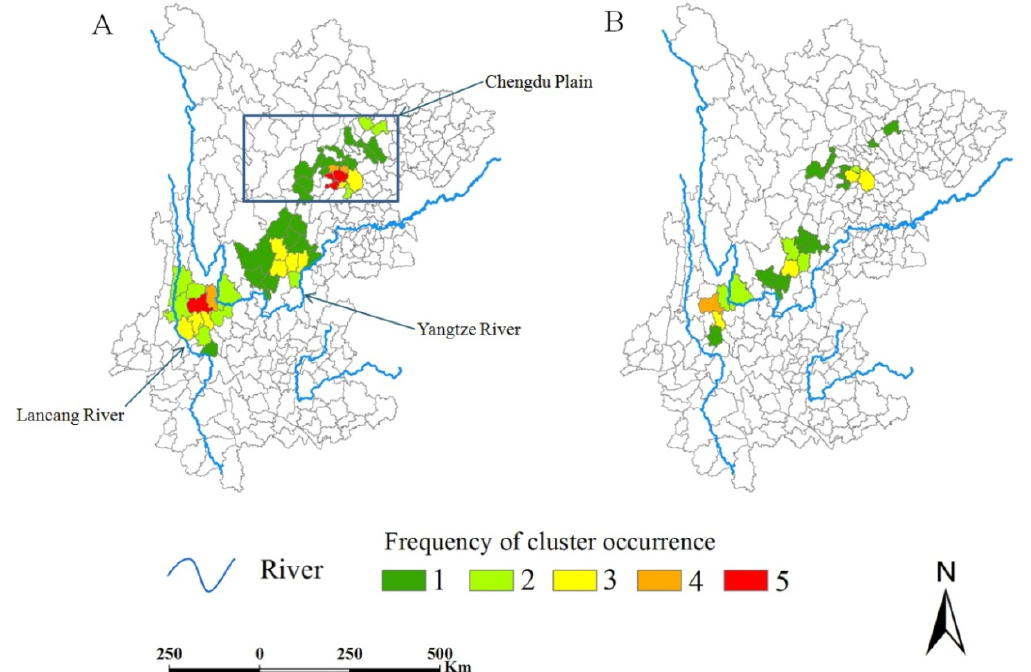
Figure 4. Frequency of cluster occurrence during the two study